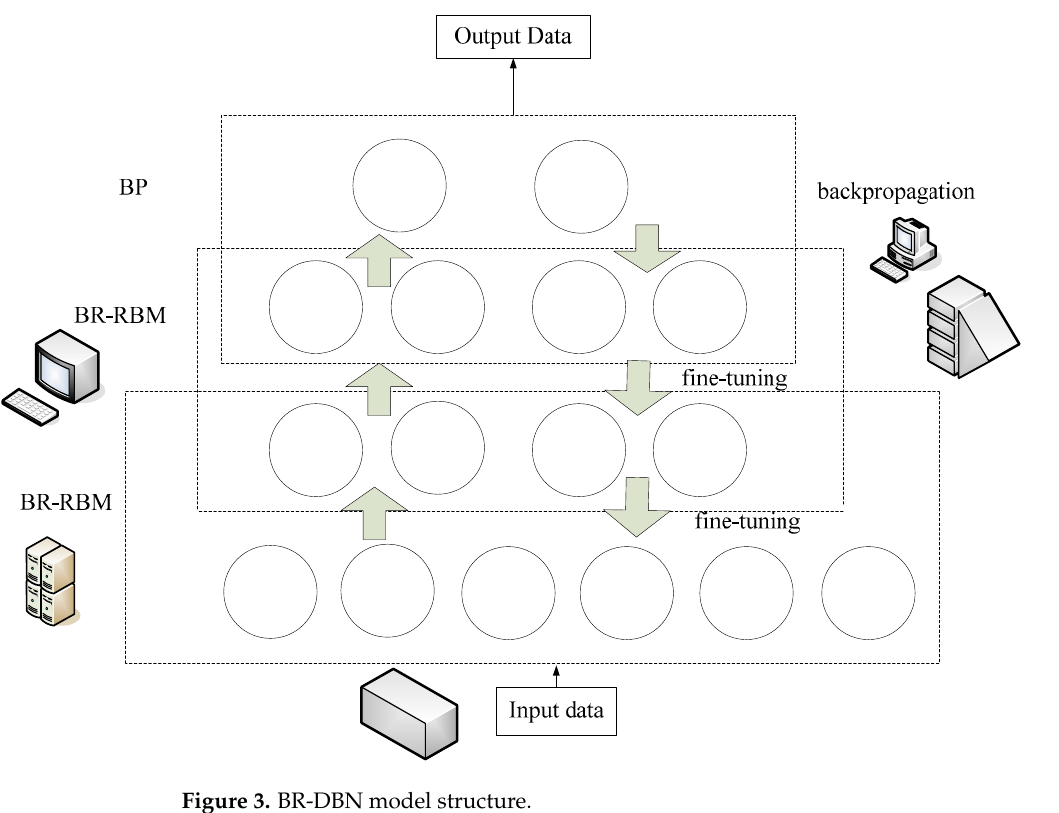
Figure 3. BR-DBN model structure.